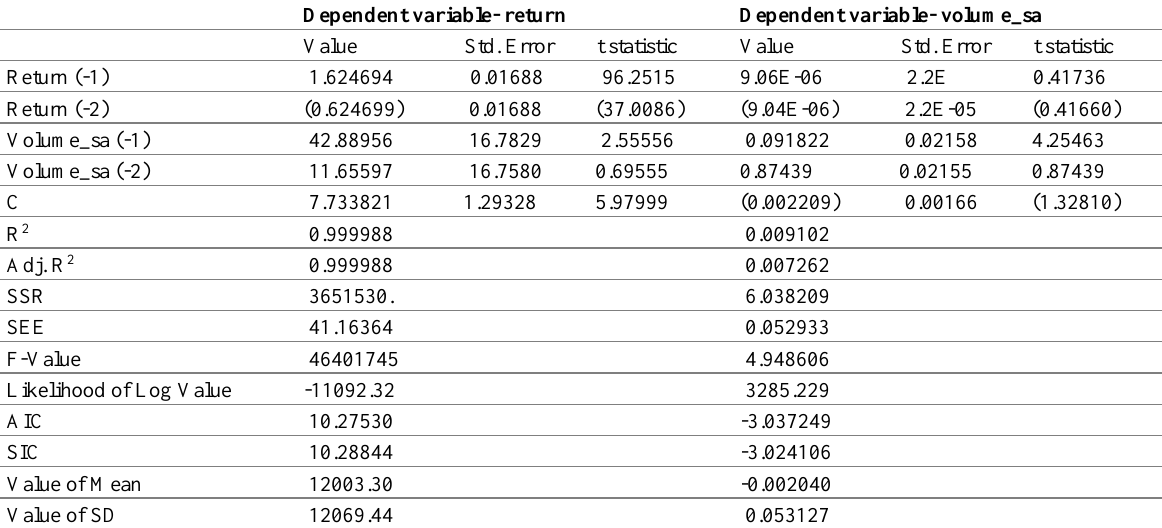
Table 4: Result of Panel VAR Between Return and Seasonally Adjusted Volumes of Stocks for Private Banks